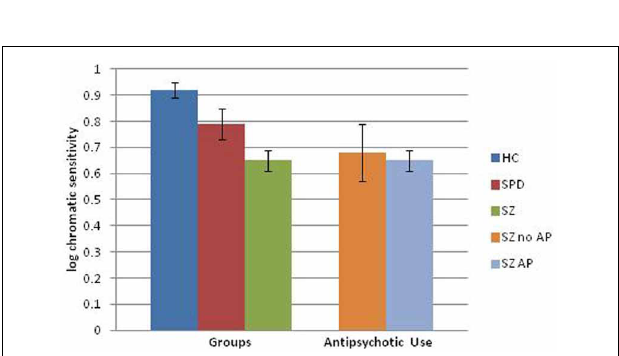
FIGURE 1 | Visual contrast sensitivity (error bars represent SEM) in the luminance condition comparing healthy comparison (HC), schizotypal personality disorder (SPD), and schizophrenia (SZ) subjects. Data from unmedicated SZ subjects as well as SZ subjects on antipsychotic (AP) medication are also shown relative to the original group analysis.